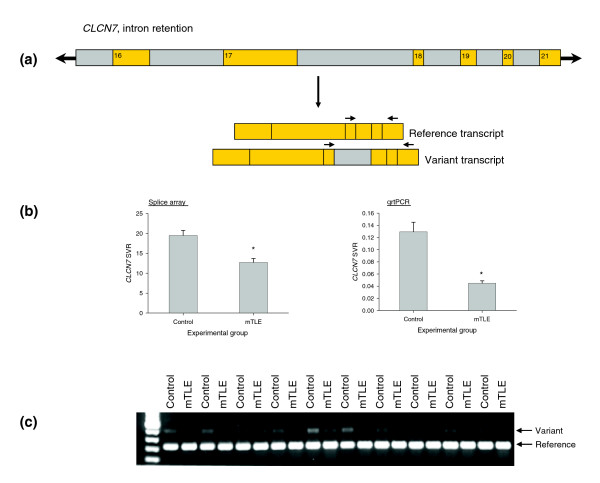
Representative mTLE-associated alternative splicing event identified using splice array technology. (a) Schematic of CLCN7 alternative splicing event associated with mTLE. Exons are shown in orange and intronic regions are shown in gray. (b) Data collected for the CLCN7 alternative splice event in control and mTLE brain tissue samples using the splice array technology (left) and quantitative rtPCR (qrtPCR, right). Data are presented as mean ± standard error of the mean; *p < 0.05 when compared to control, Student's t-test. (c) rtPCR confirmation of the pattern of transcript expression in brain tissue collected from ten subjects from each group. Both reference and variant transcript forms were amplified using the following primer sequences (indicated in the figure by arrows above mRNA transcripts): CLCN7F-GGCAAATACGCCCTGATG, CLCN7R-CTCAGCACGTCCACAATGAC.